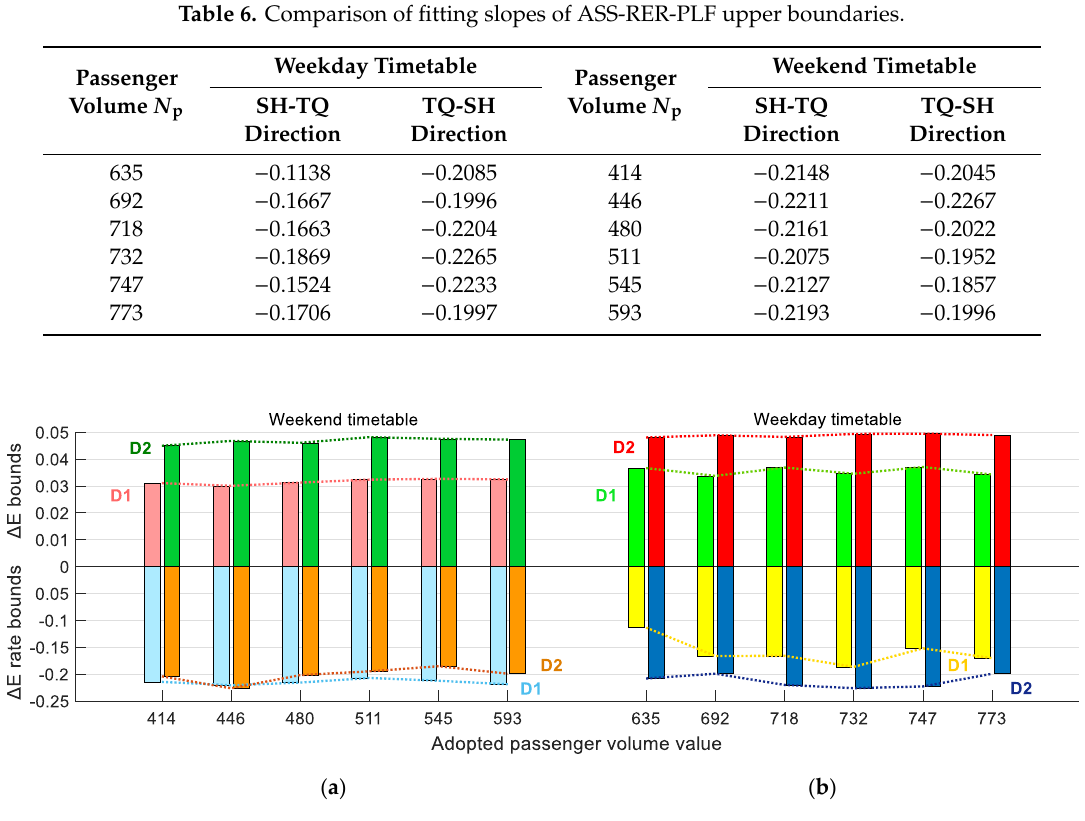
Figure 22. Comparison of fitting slopes corresponding to the derived boundaries with different passenger volume values. ( a ) Weekend timetable results; ( b ) Weekday timetable results.